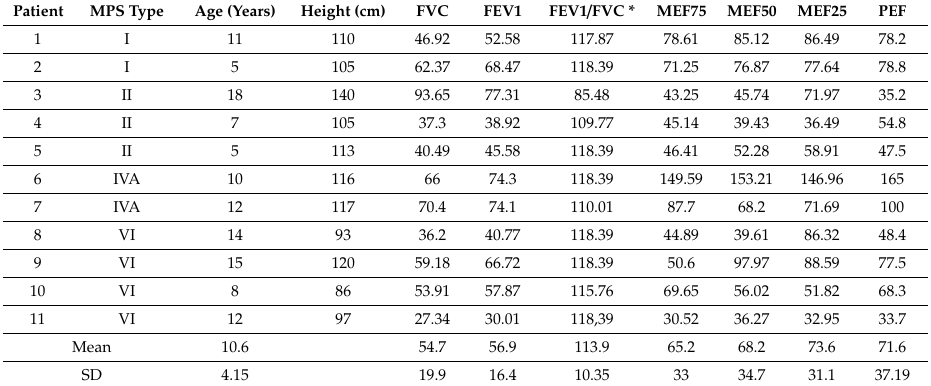
Table 4. Spirometry results (%) in children and adolescents with di ff erent types of